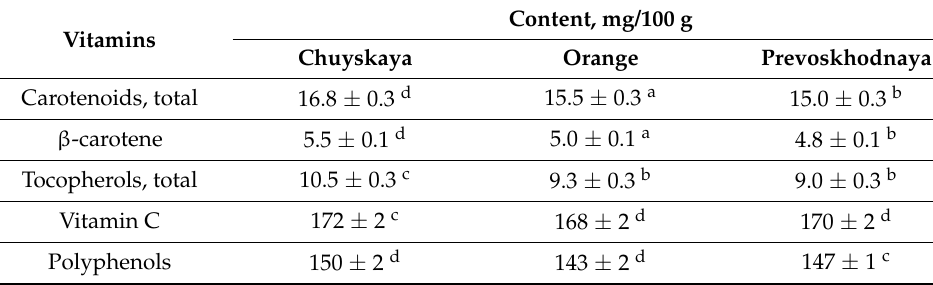
Table 2. Vitamins in the sea buckthorn